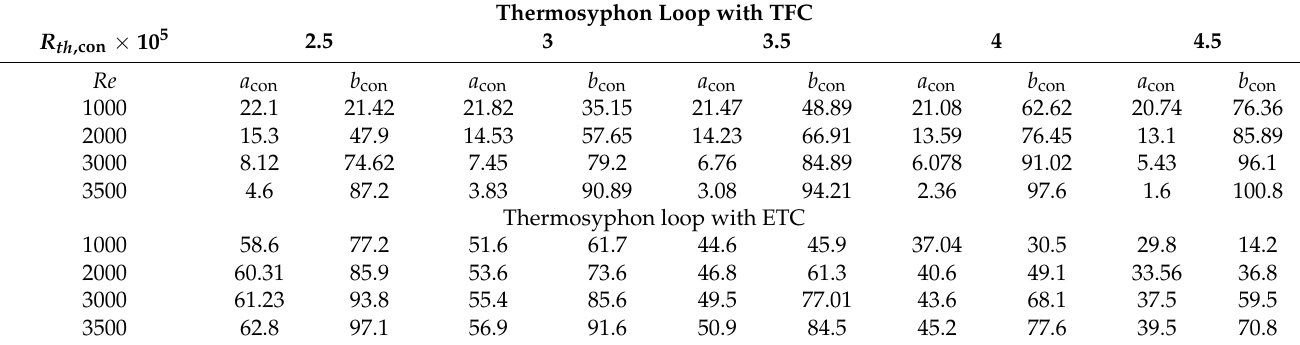
Table 3. Coefficients of a con and b con in Nu con correlation. Thermosyphon Loop with